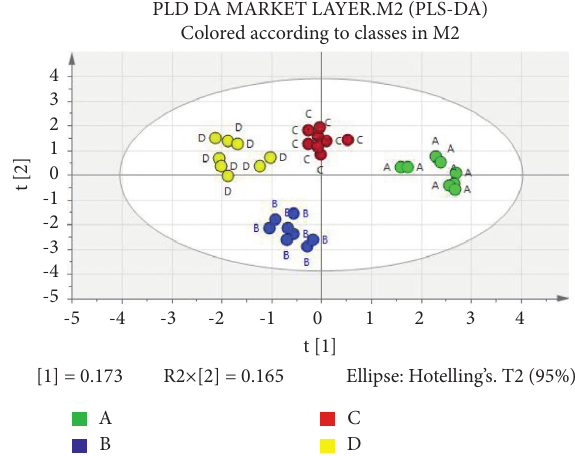
Figure 4: The partial least squares-discriminant analysis (PLS-DA) score plot of control and market samples of layer chicken in terms of proximate, color, and texture properties. Colored circles are represented by CLC � control layer chicken (green);